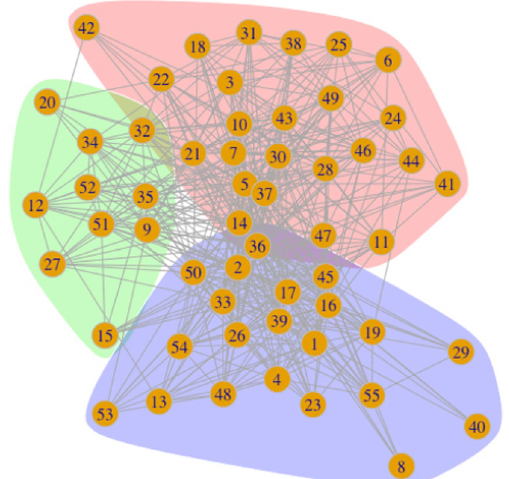
Fig. 3 Three groups of systems thinkers revealed from the Twitter network: the purple group is enriched by holistic systems thinkers, the pink group is enriched by reductionist systems thinkers, and the green group is enriched by middle systems